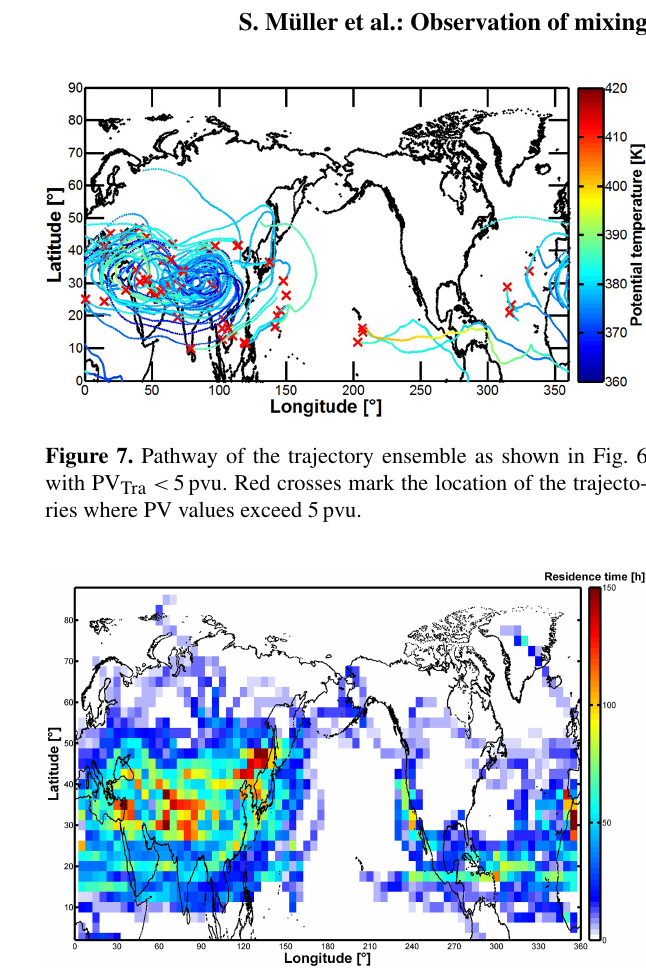
Figure 8. Residence time in hours of the trajectory ensemble as shown in Fig. 6 for − 50 days <t Tra < − 30 days (2.5 ◦ latitude and 5 ◦ longitude bins). Note the long residence time in the ascending region as indicated in Fig.